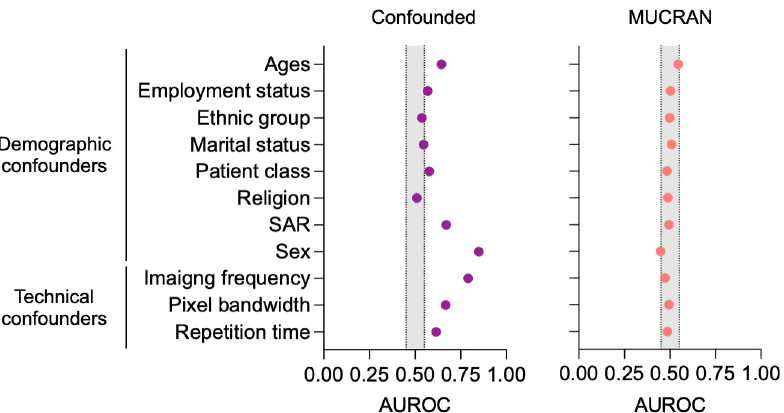
Fig 3. Prediction of confounding factors. Averaged results of model performance for predicting demographic and technical confounding factors were reported as area under the receiver operating characteristics (AUROC) for the confounded and regressed